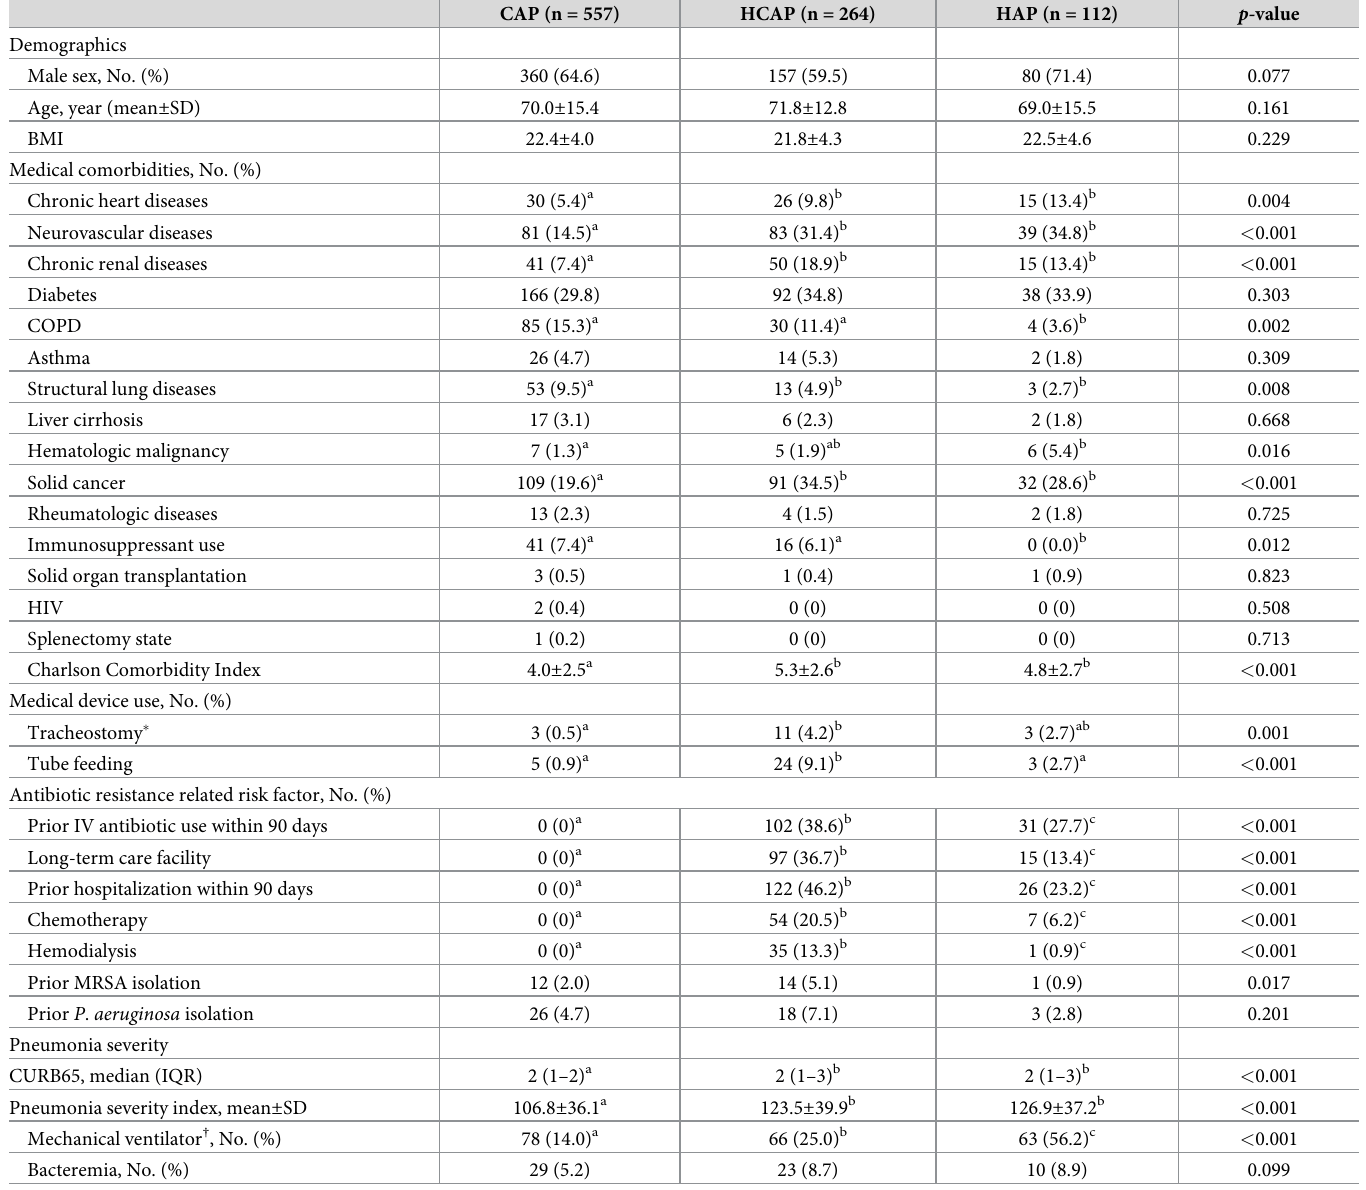
Table 1. Baseline characteristics of hospitalized patients with